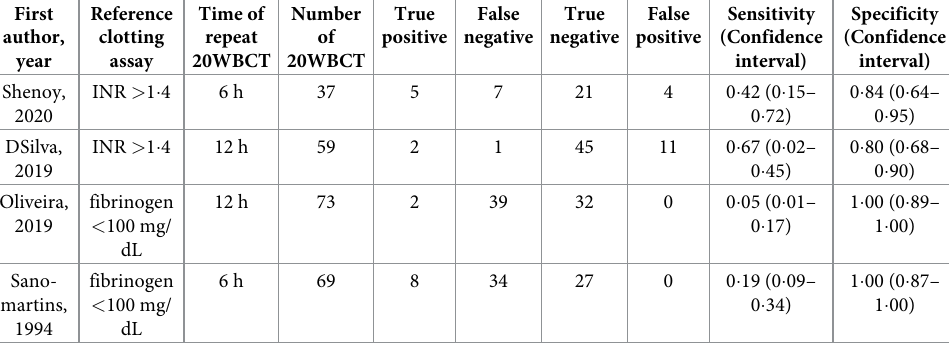
Table 3. Summary of studies performing 20WBCT after